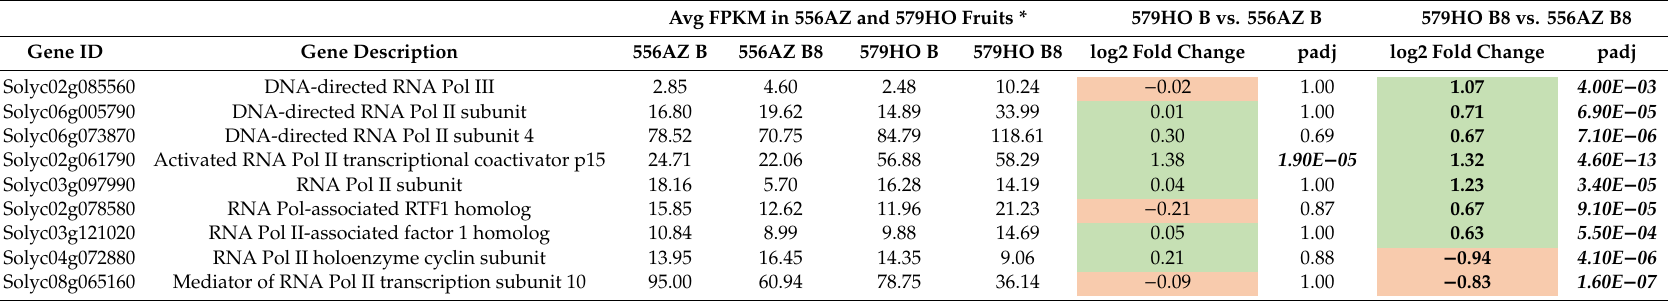
Table 1. Di ff erential expression of RNA polymerase genes in 556AZ and 579HO tomato fruit at breaker (B) and breaker + 8 (B + 8) stages.